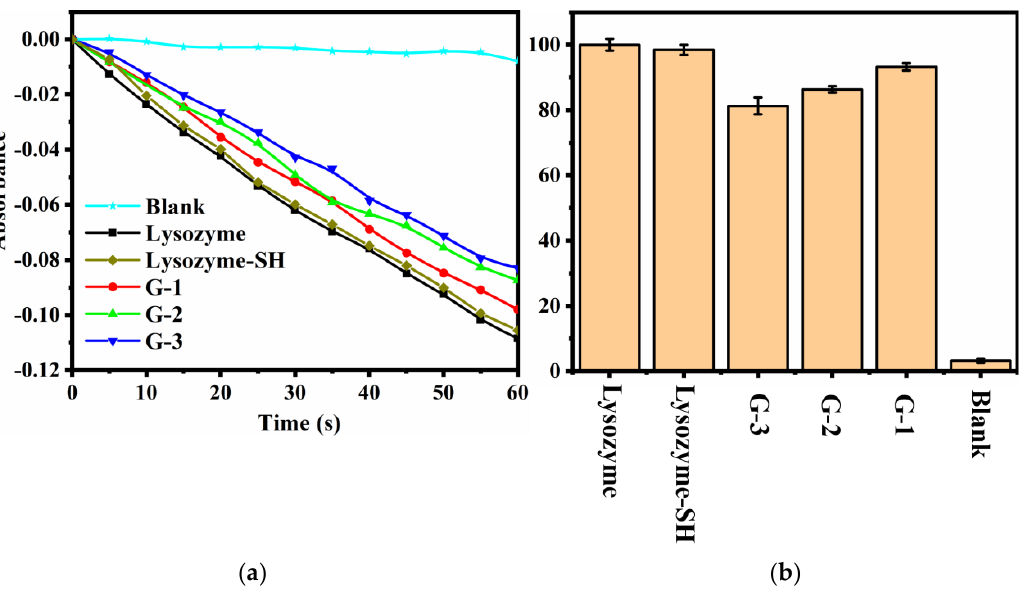
Figure 6. ( a ) Activity kinetics of lysozyme, lysozyme-SH and the three bioconjugates hP(DEGMA- co -OEGMA)- star -PLZ; ( b ) relative activity of lysozyme and the three bioconjugates hP(DEGMA- co - OEGMA)- star -PLZ.